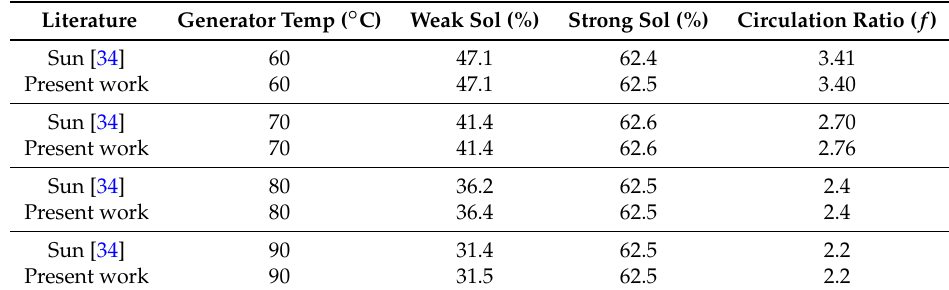
Table 6. Comparison of the flows of solution and refrigerant ratio at varied generator temperature ( T E = 2.5 ◦ C, T C = 20 ◦ C, and T A = 20 ◦ C).